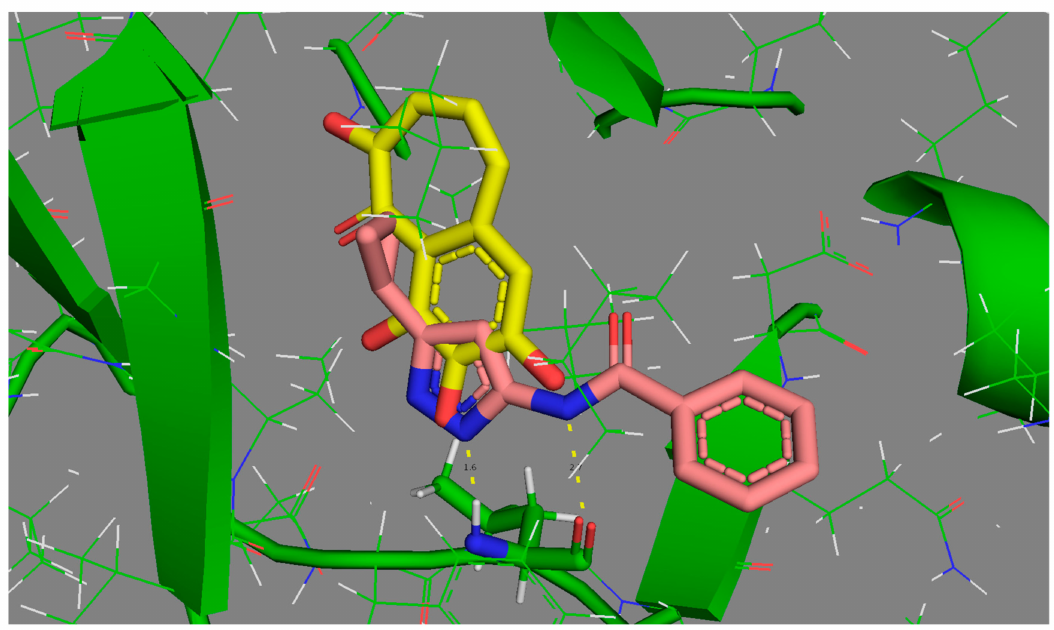
Figure 5. Comparative binding modes of easily reproducible 1VYZ (pink) versus “di ffi cult” 3TIY (yellow carbon skeleton). Both feature the key hydrogen bonding “fork” to Leu 83 (green carbon skeleton in stick mode, at the bottom of the active